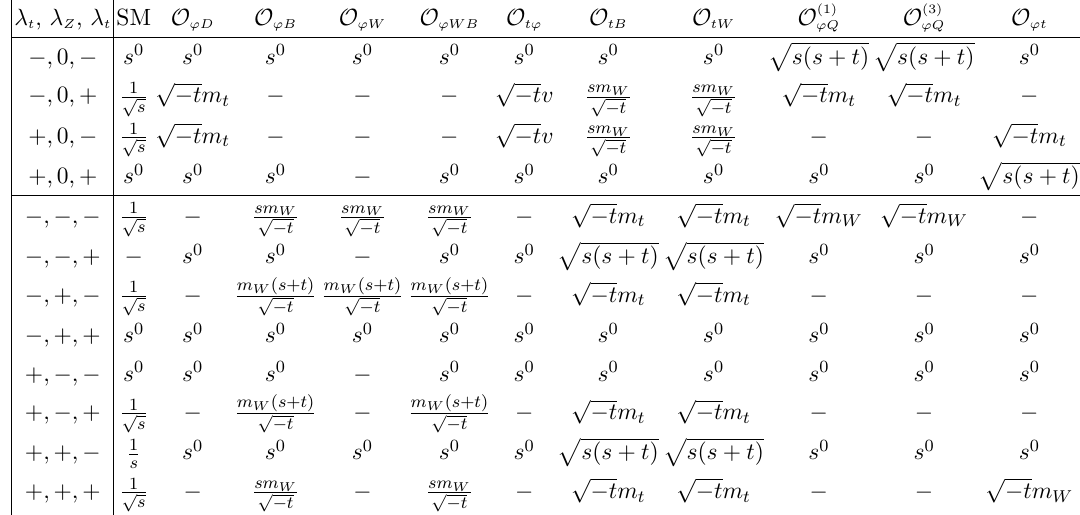
Table 17. Helicity amplitudes in the high-energy limit ( s Overall multiplicative factors are dropped and only the schematic energy dependence is retained for the SM contribution. Helicity entries marked by ‘ section 5.2.1 for a discussion of the results.